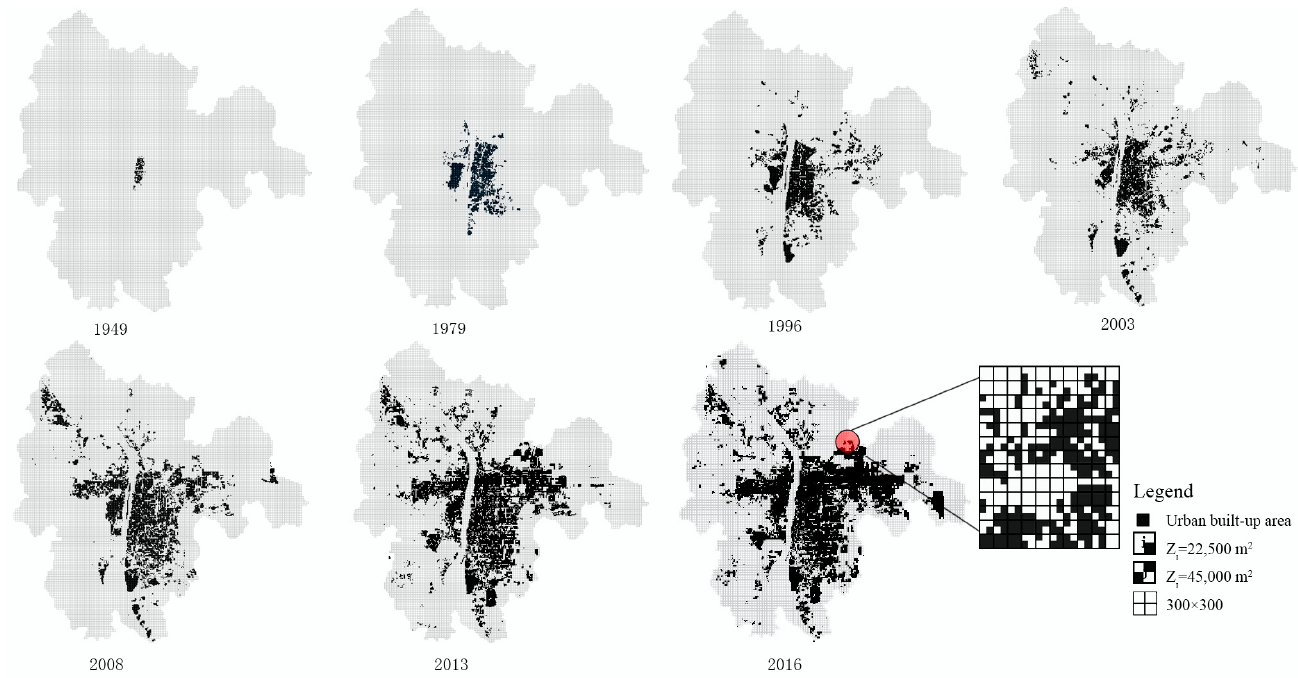
Figure 2. GIS raster analysis based on the urban land